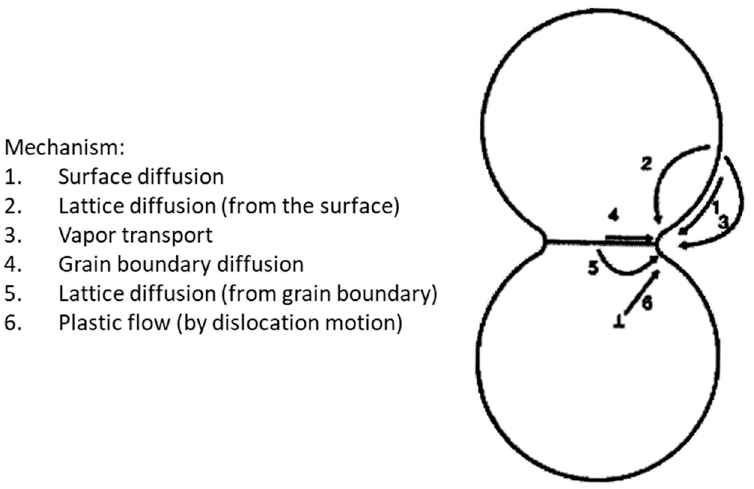
Figure 12. Material transport paths during sintering [96] .